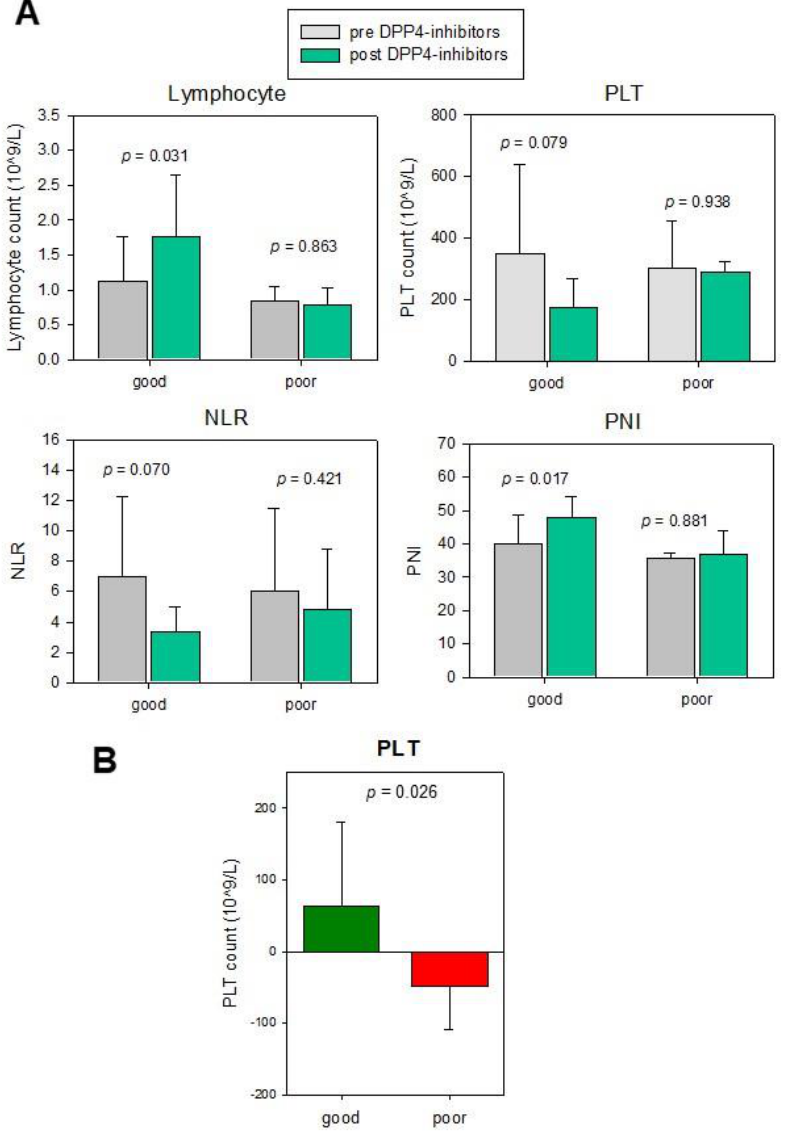
Figure 4. The immune cell profile of CRC patients as a potential biomarker for efficacy of DPP4-inhibitor treatment. ( A ) Changes of lymphocytes, PLT, NLR and PNI before and after DPP4-inhibitors are significant in good prognosis patients but insignificant in the poor prognosis group. ( B ) Change of post vs. pre-operation PLT count was significantly associated with DPP4-inhibitor